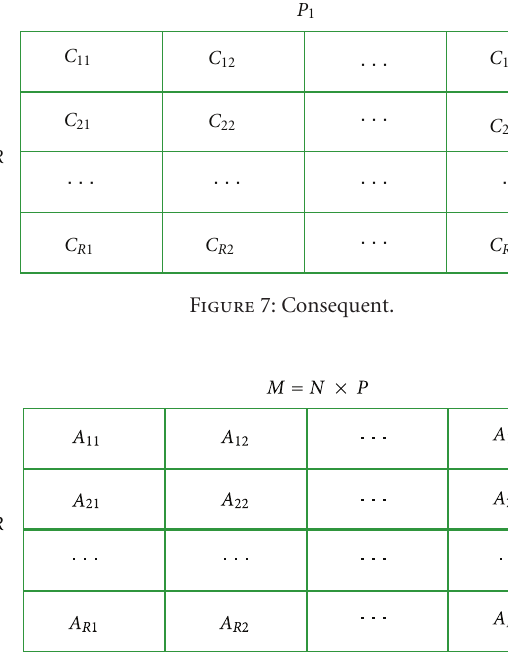
Figure 8: Antecedent.